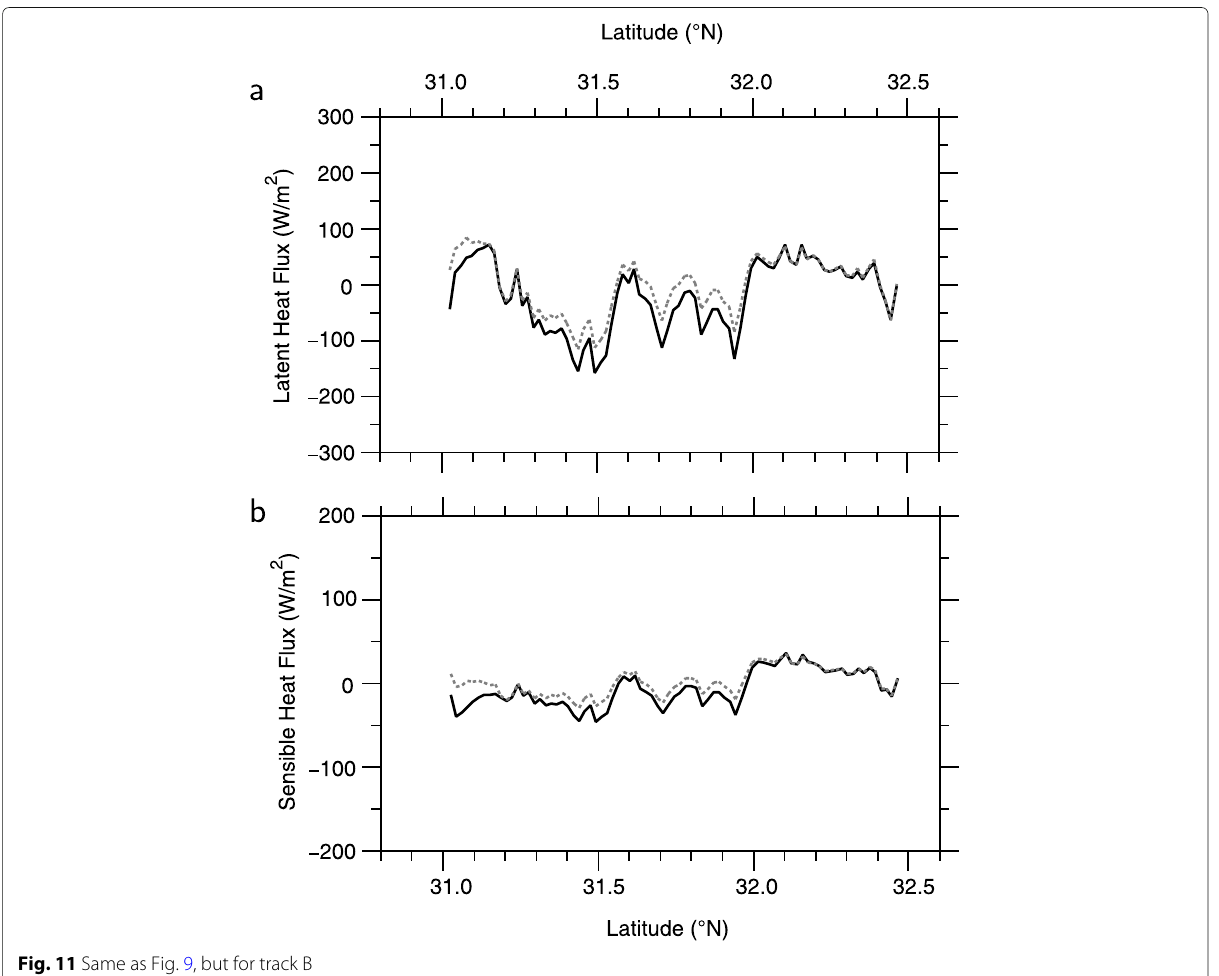
Fig. 11 Same as Fig. 9, but for track